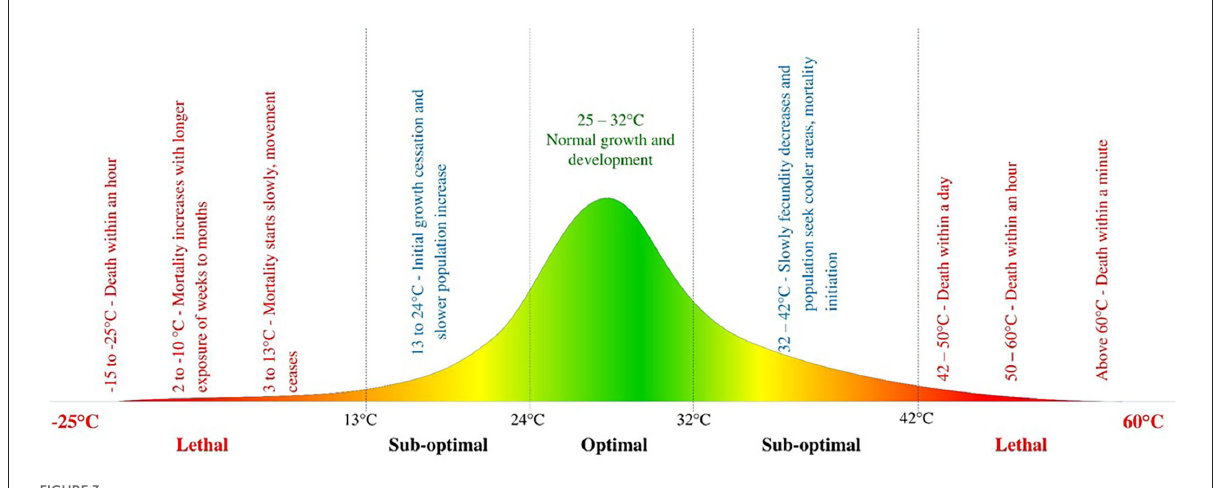
FIGURE3 Relationship between temperature and insect growth and